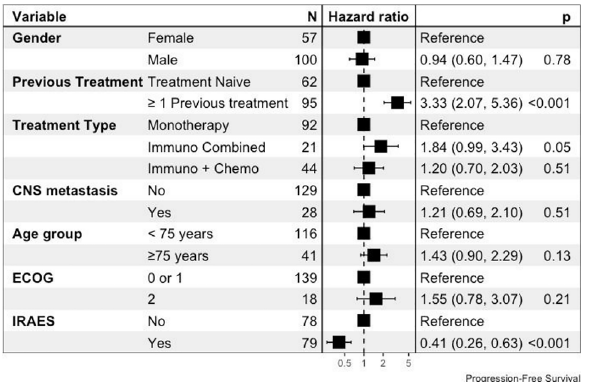
Figure 3. Results from Forest Plot models for progression-free survival (PFS). Legend: CNS: Central nervous system; IRAES: Immune-related adverse events.